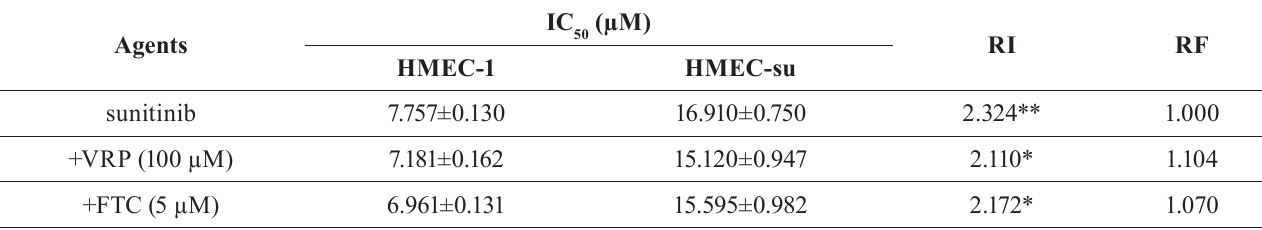
TABLE III - Effects of P-gp and ABCG2 inhibitors in resistance HMEC-su cells